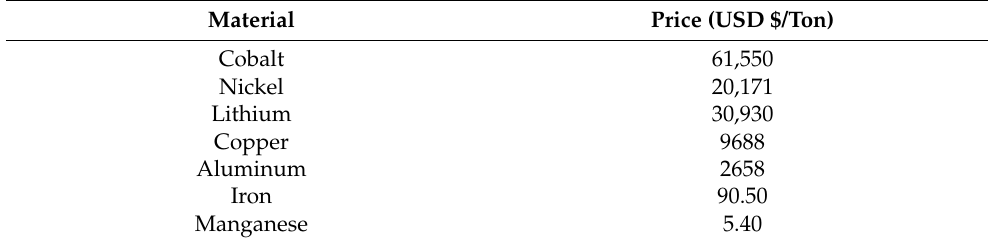
Table 2. Market values of the main elements of vehicle lithium-ion batteries